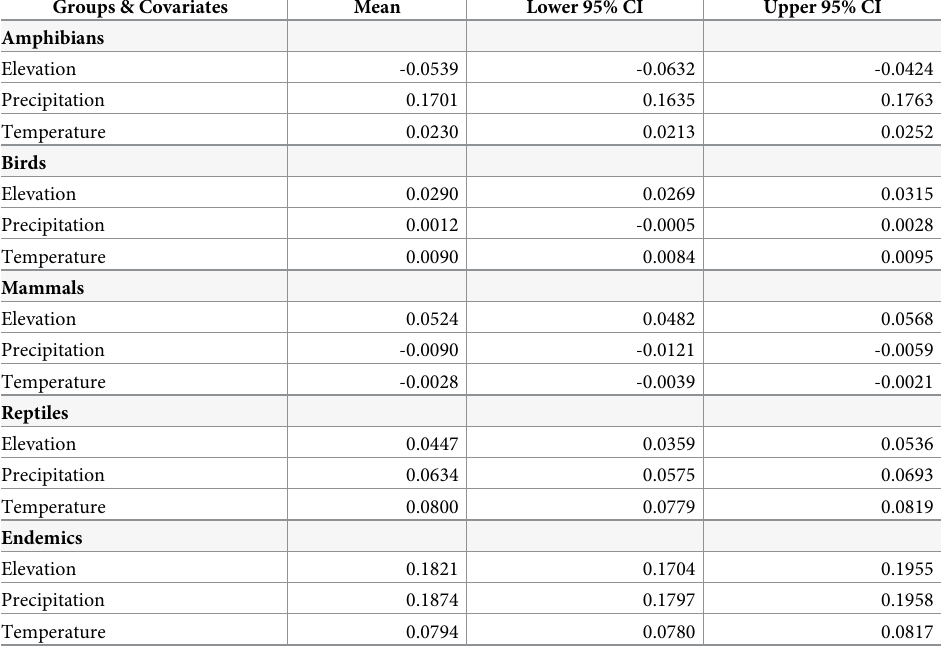
Table 1. Bayesian spatial Poisson model coefficient estimates for fixed effect covariates. Models for the all five tax- onomic groups included elevation, precipitation, and temperature as fixed effect covariates. All covariates were signifi- cant except for the bird species richness and precipitation.